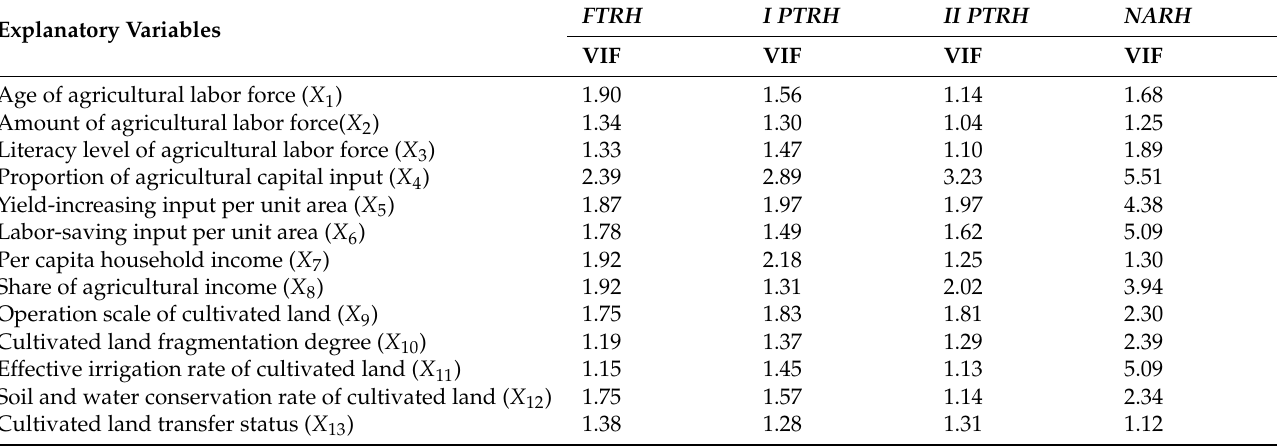
Table 6. The multicollinearity diagnosis results of explanatory variables for different types of rural